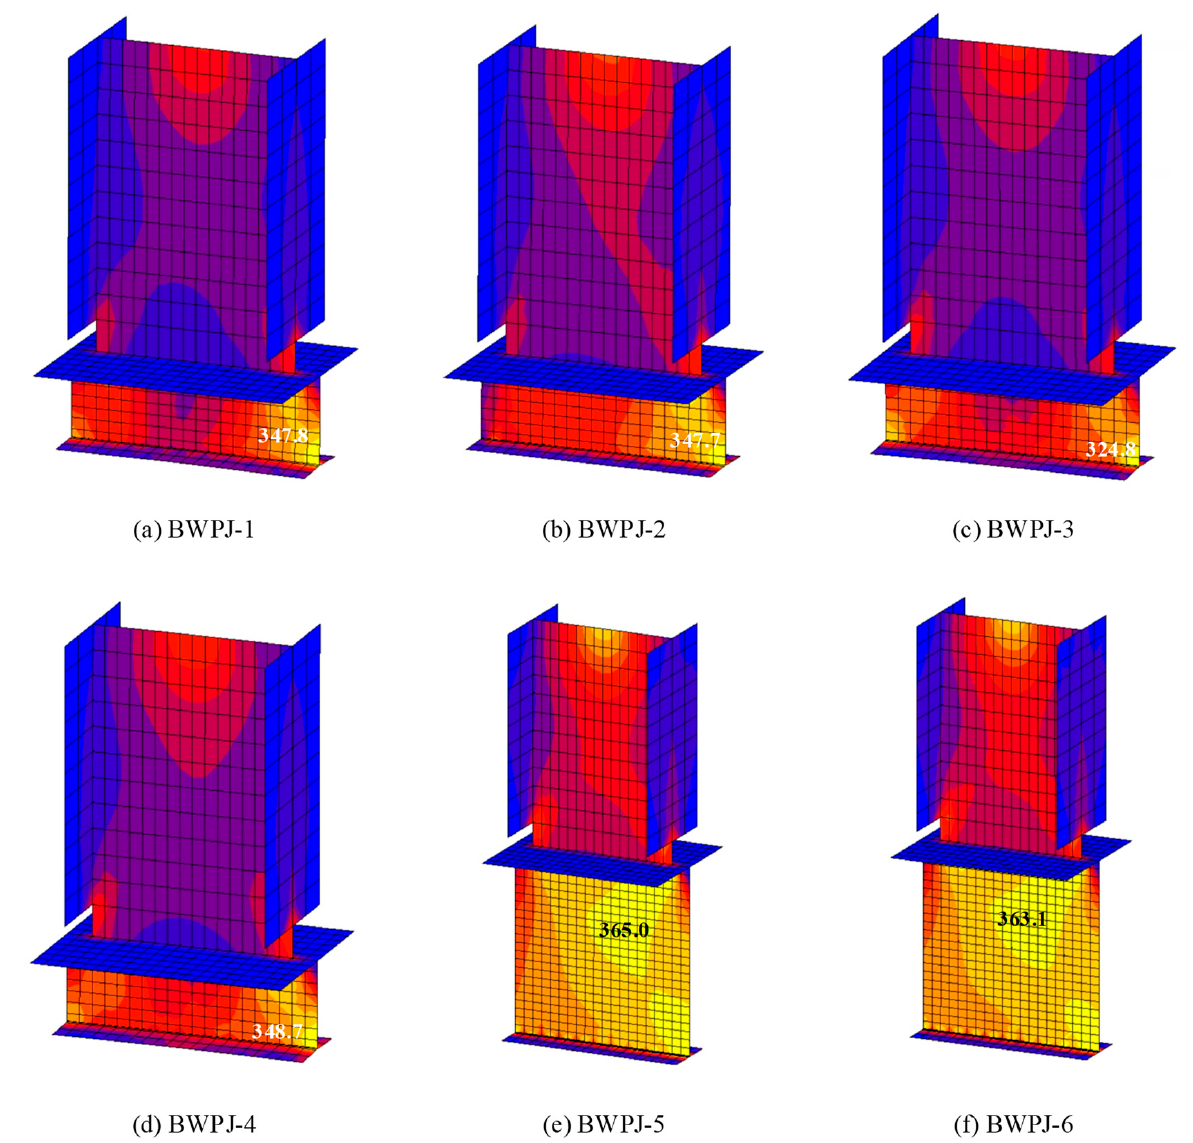
Figure 15. Equivalent von Mises stress (MPa) of the steel components at the failure point.